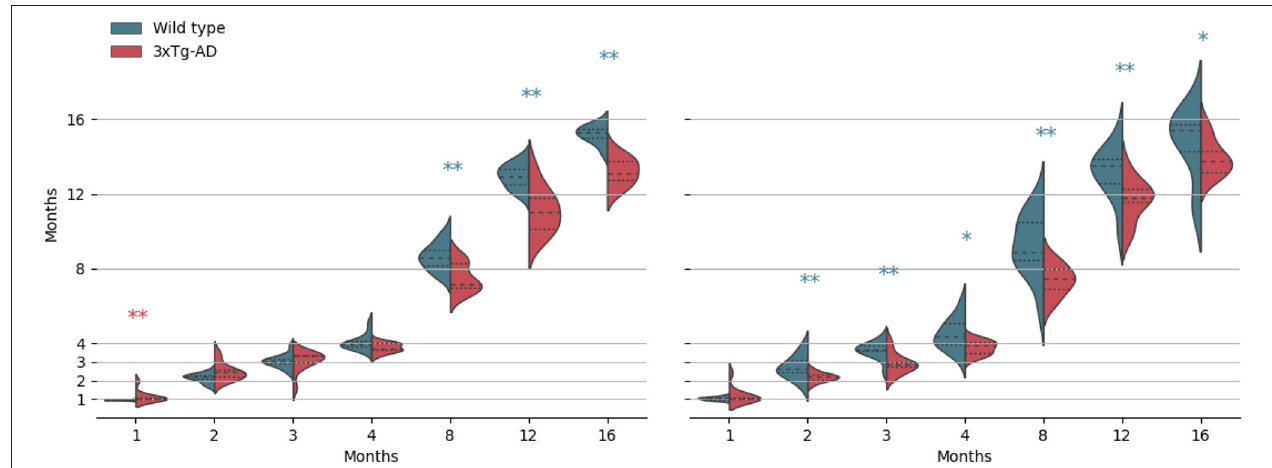
FIGURE 3 | Kernel density estimates of the predicted age, separated per class (wild-type vs. 3 × Tg-AD), for each acquisition time-point. From left to right, results for the wild-type and the 3 × Tg-AD trained models. Median (dashed), and first and third quartiles are shown. * p < 0.05, ** p < 0.01. Asterisk color indicates a higher median